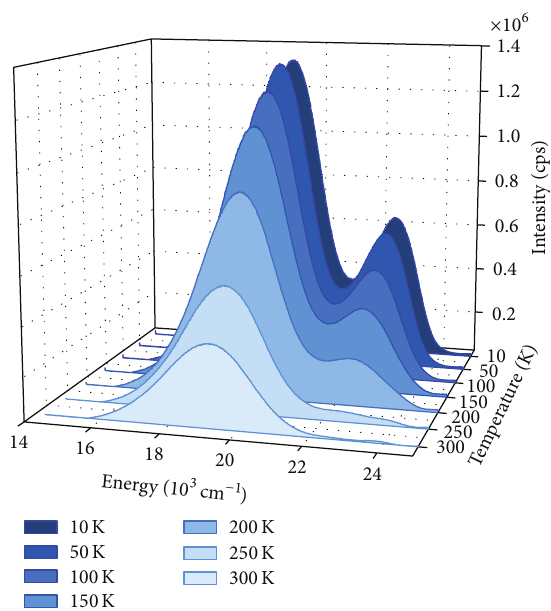
Figure 11: Effect of decreased temperatures on the emission spec- = 27 620 cm −1 ) of 5 . trum ( ̃𝜐 ex